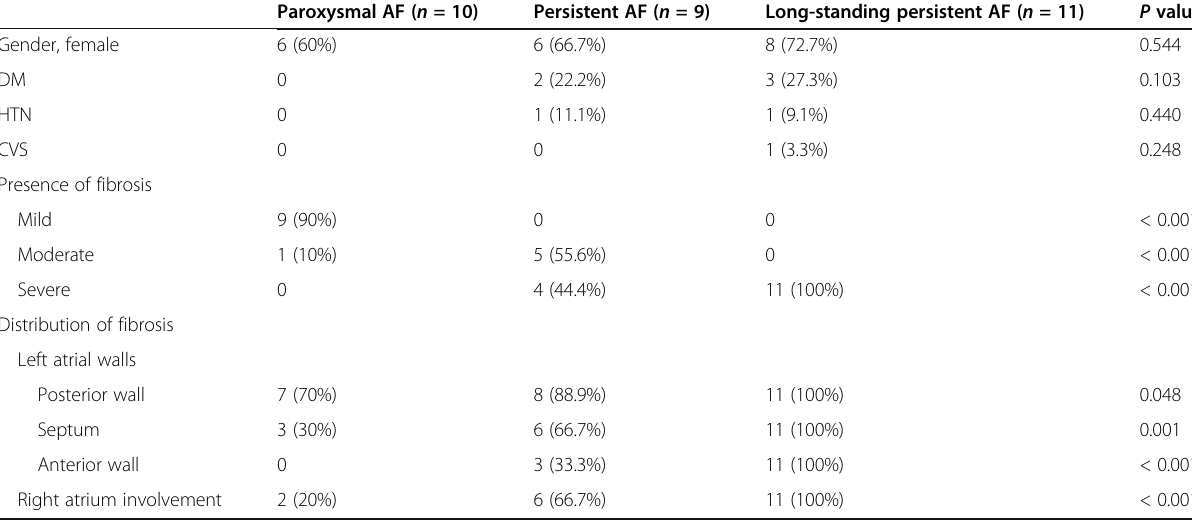
Table 4 Comparison between patients according to the type of AF regarding demographic data and atrial fibrosis Paroxysmal AF ( n =